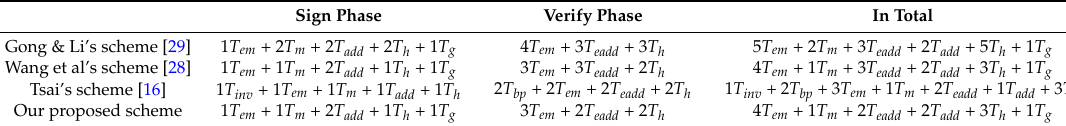
Table 8. A comparative summary: